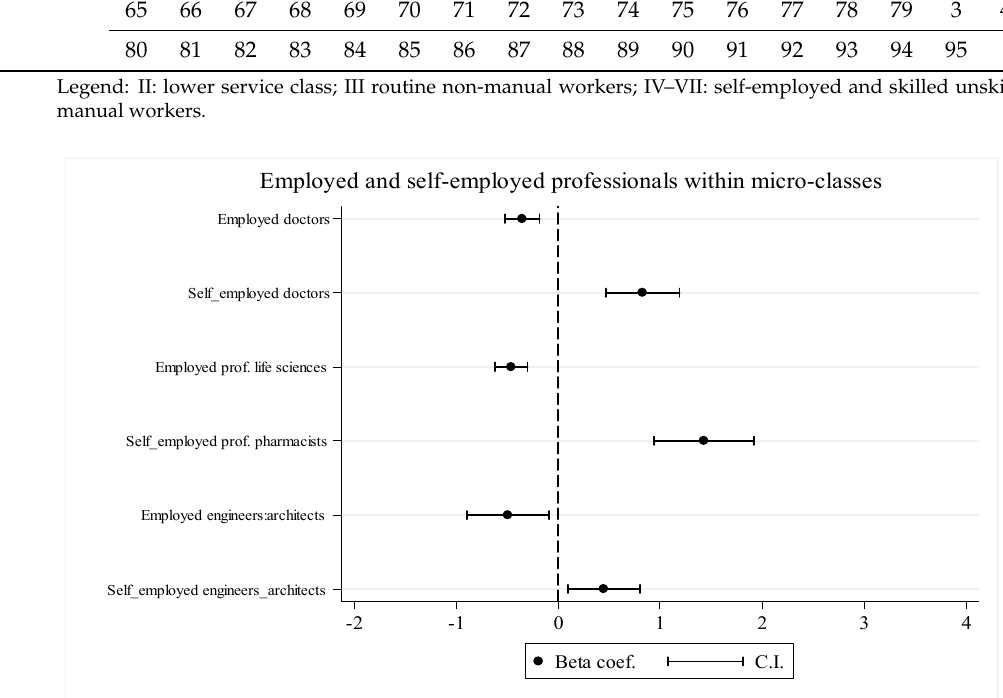
birth, geographical areas, gender, education, and nationality. Figure A2. Average marginal effects from logistic regression models for the probability of being in the higher service class according to big- and meso-classes (ref. cat. working-class VII). Estimates are at net of controls (gender, geographical areas, cohort of birth, and education). Black dots denote the AME of social classes for men, and the gray triangle for women and black lines denote 95% confidence intervals. Legend: higher service class (I), lower service class (II), routine non–manual workers (III), petite bourgeoisie (IVab), farmers (IVc), skilled manual workers (V–VI). Source: ILFI (1997–2005).